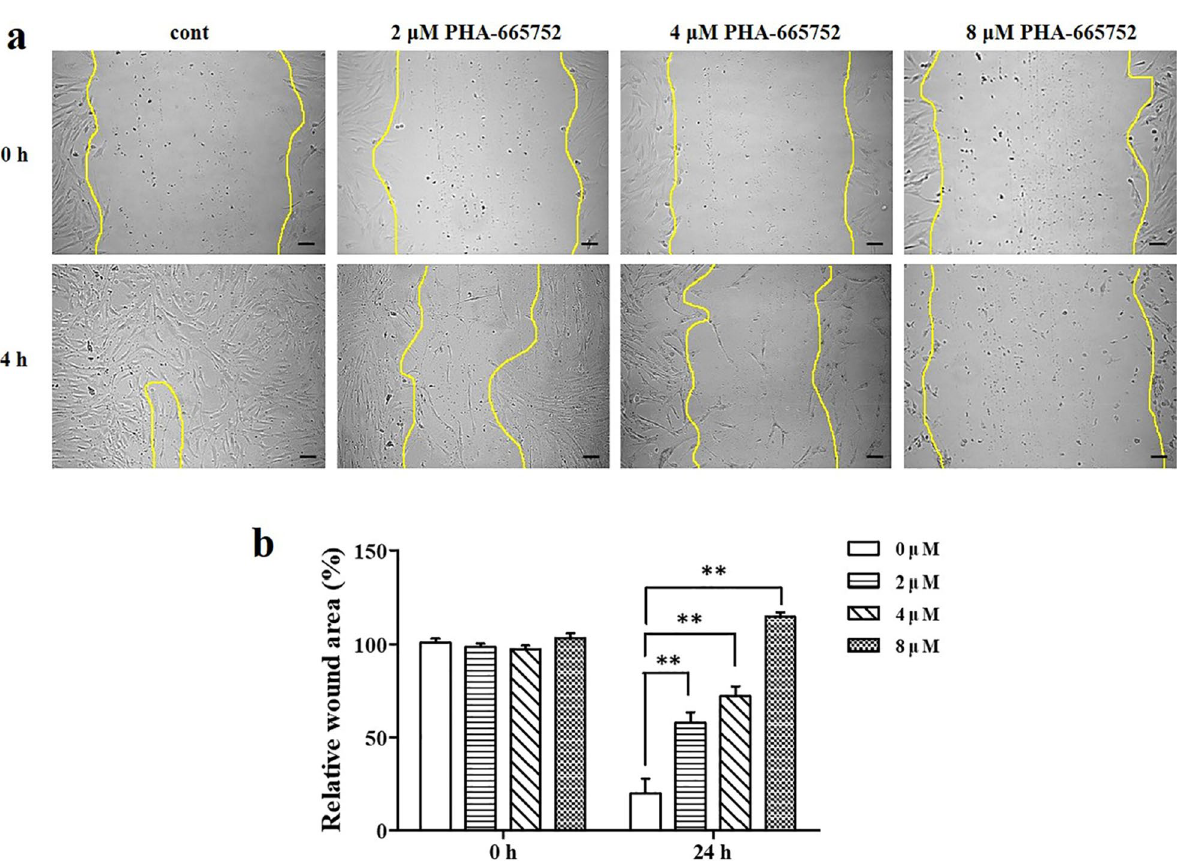
Figure 3. PHA-665752 inhibits the migration of human keloid-derived fibroblasts. ( a ) Keloid fibroblasts were grown to confluence on 24-well plates and treated with 3 different concentrations of PHA-665752 for 24 h (Original magnification: 100 × , Scale bar = 100 µm). ( b ) Quantitative analysis of wound closure (**represents p <